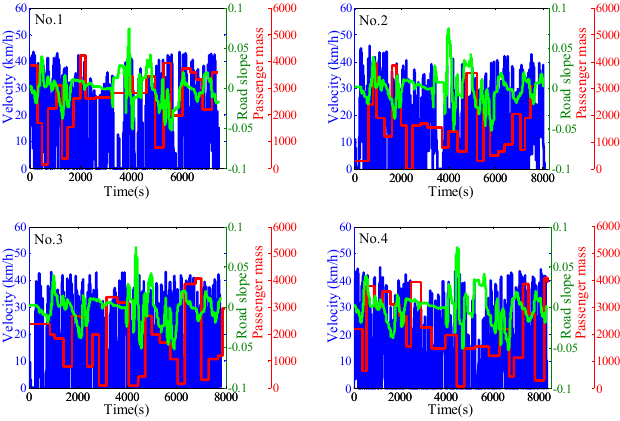
Figure 7. The combined driving cycles.